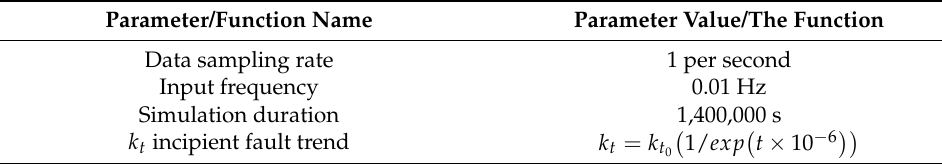
Table 9. Parameters for the days span simulation.